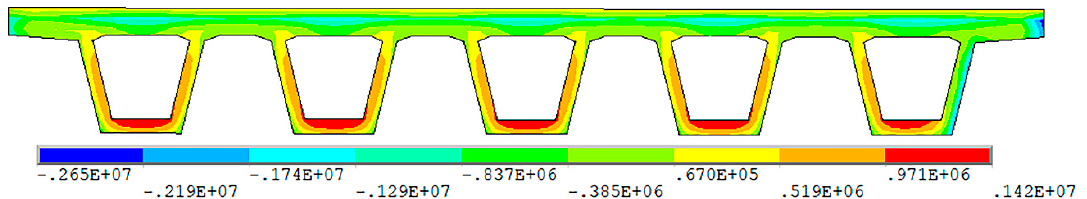
Figure 12. Longitudinal normal stress distribution under maximum positive lateral temperature gradient (unit: Pa).